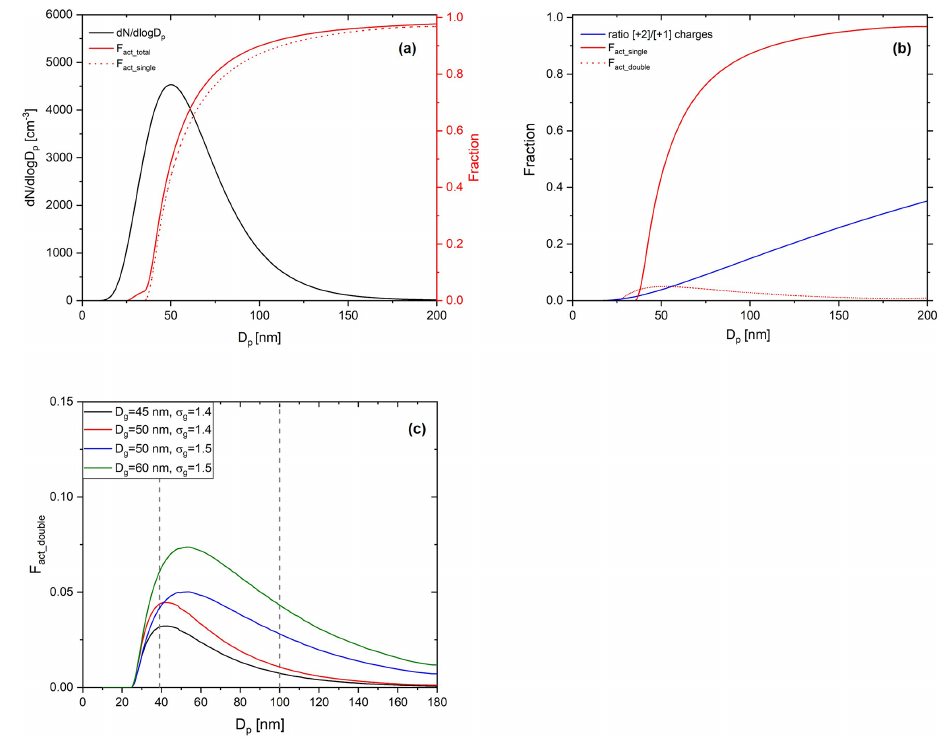
Figure 4. Calculated ideal activation fraction for lognormally distributed, charge-equilibrated particles transmitted in the BS2-CCNC system. Shown are the (a) assumed lognormal particle size distribution (black solid line, left ordinate, N = 2000cm − 3 , D g = 50nm, and σ g = 15), total activation fraction (red solid line), activation fractions by singly charged particles (red dashed line), (b) activation fraction by singly charged particles (red solid line) and doubly charged particles (red dashed line), and the ratio of [+ 2 ] / [+ 1 ] charges (blue solid line), which refers to f (D,n = + 2 )/f (D,n = + 1 ) with mobility diameter at charge equilibrium. f (D,n) is the fraction of particles carrying n charges at charge equilibrium by Wiedensohler (1988) and (c) activation fractions by doubly charged particles ( F act_double ) for variant particle size distributions. Information on each particle size distribution is presented in the legend of the